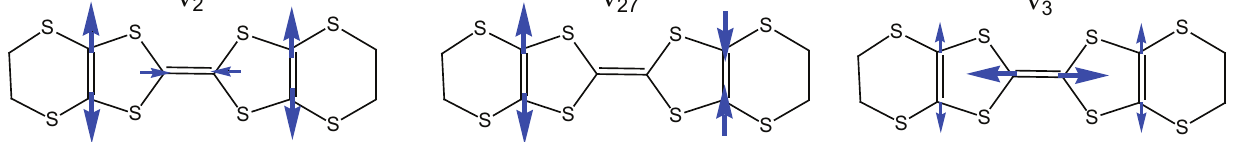
Figure 1. C=C stretching modes of BEDT-TTF. The ν